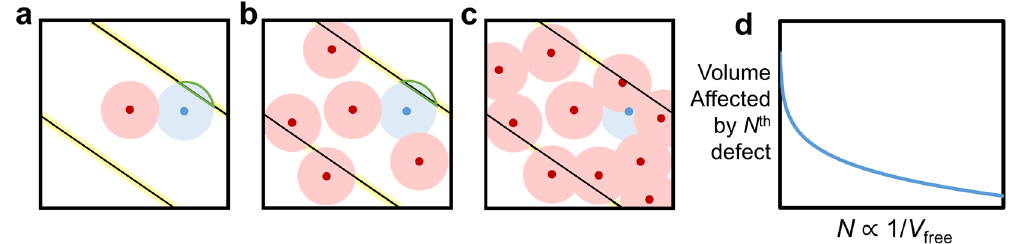
Figure 1. Schematic 2D simplification of 3D samples, illustrating the relationship between material volume, volume affected by defects, and the effects of new defects. ( a ) Shown is a single grain with three domains, separated by two domain walls. Free material volume is shown in white, pre-existing defects and the volume they affect in red, and a newly-introduced defect in blue. A larger free volume results in greater mean volume pinned by the new defect. ( b , c ) With increasing number of pre-existing defects ( d ) the volume pinned per new defect is reduced. Furthermore, the weighting function is employed to account for nonlinear defect interactions, such as those between defects and domain walls shown in green in ( a ) and ( b ). As available sites for new defects to impact domain walls are reduced with greater numbers of pre-existing defects, the weight of new-defect impact on free material volume is modified. The available domain wall area for interactions with new defects is highlighted in